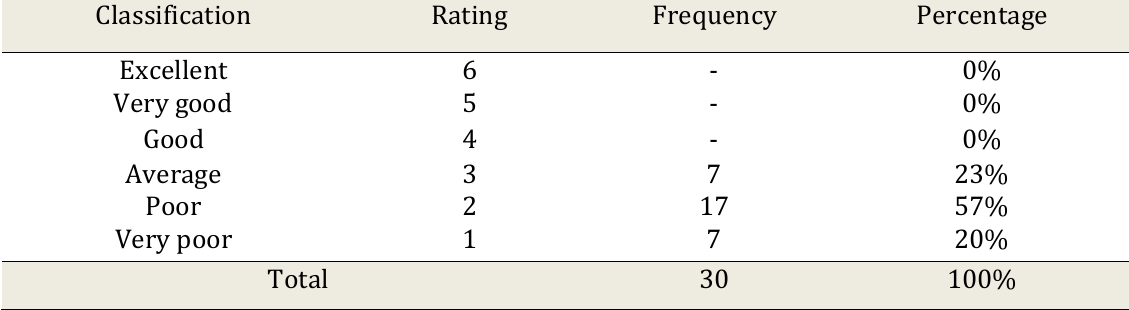
Table 4.19 The Rate Percentage Score of Students' Fluency in Pretest Result in Control Class Classification